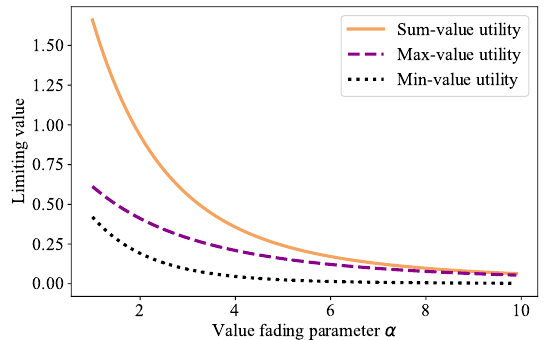
Figure 5. Comparison of sum-, max-, and min-value of payoff.